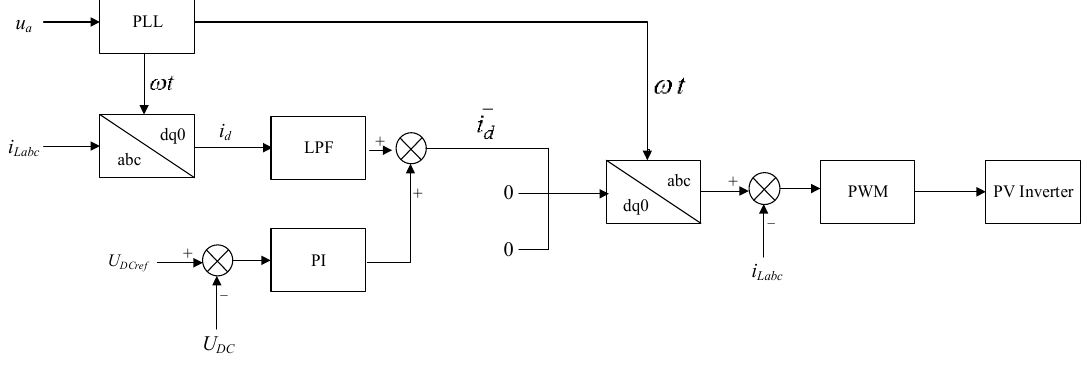
Figure 2. Structure of night control mode.